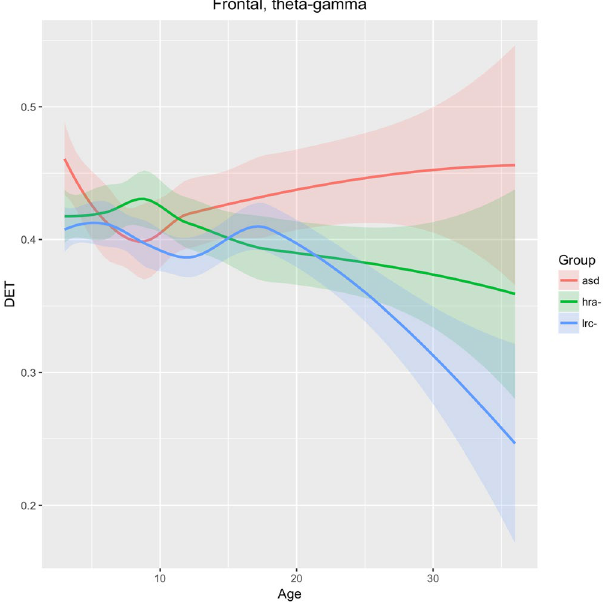
Figure 11. Developmental trajectories for DET in the entire frontal region (Fp1 + F7 + Fz + F8 + Fp2 sensors) in higher frequencies (beta + gamma) for ASD, LRC − , and HRA −